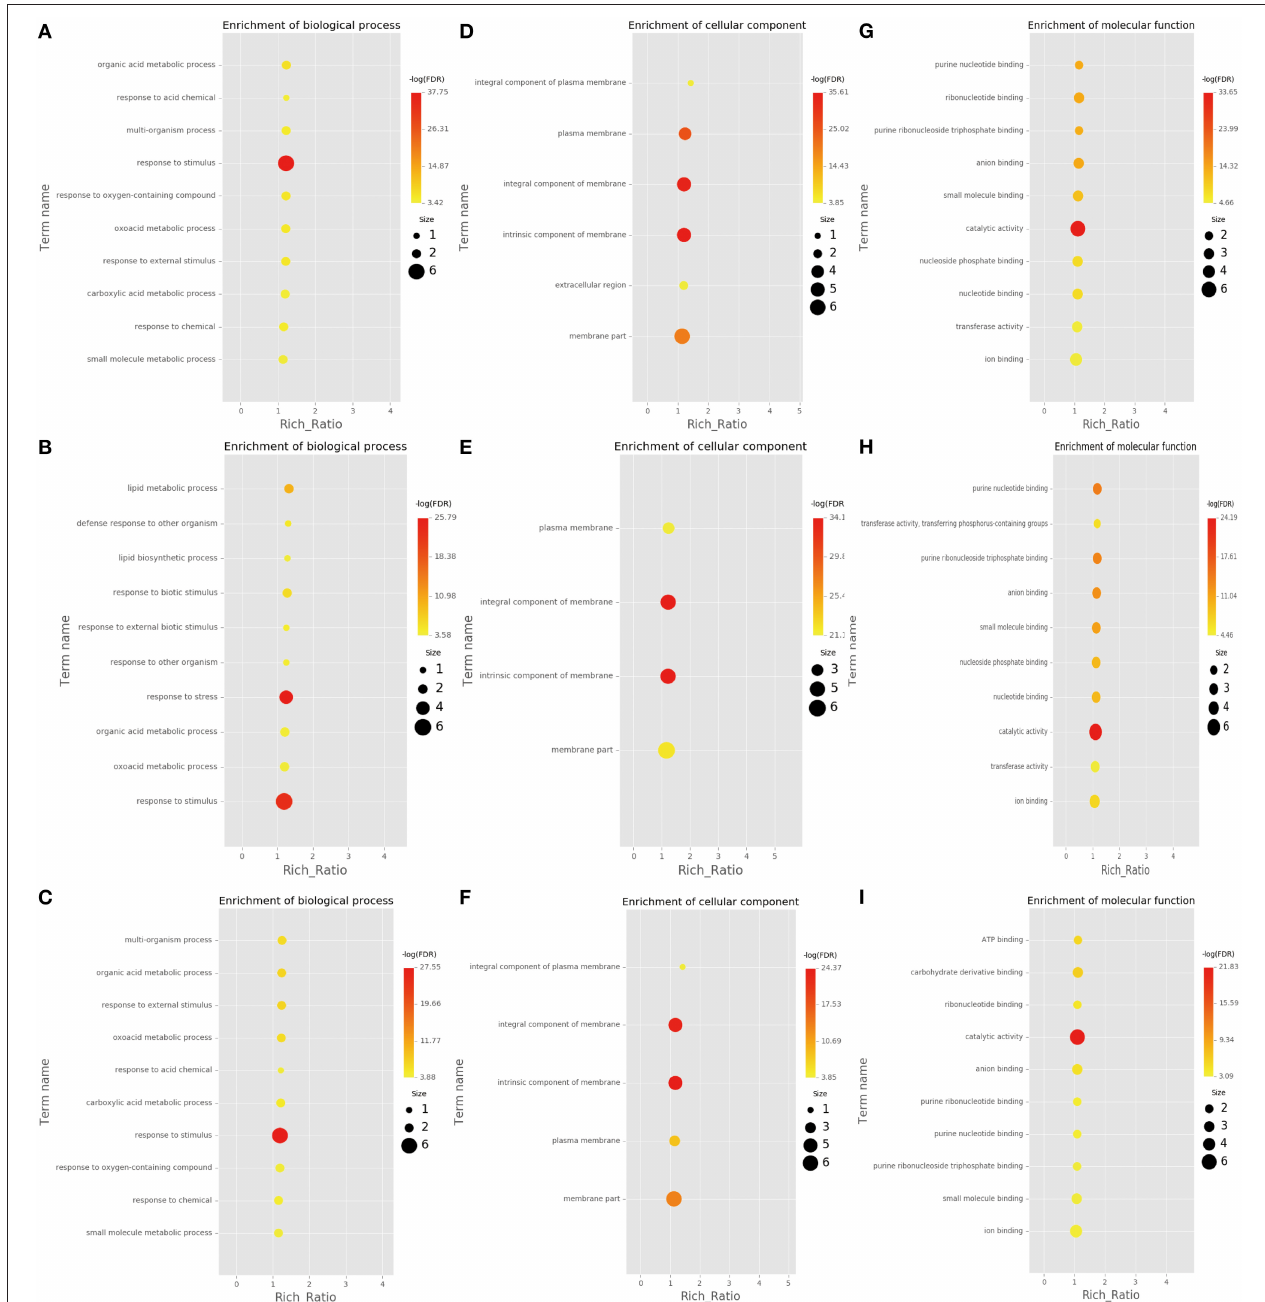
FIGURE 5 | Most significantly enriched gene ontology (GO) terms for differentially expressed genes (DEGs) identified by RNA sequencing analysis of two poplar species under cold conditions. (A–C) GO terms for DEGs between P. ussuriensis and P. trichocarpa at 25 ◦ C. (D–F) GO terms for DEGs between P. ussuriensis and P. trichocarpa at 3 ◦ C. (G–I) GO terms for DEGs between P. ussuriensis and P. trichocarpa at − 3 ◦